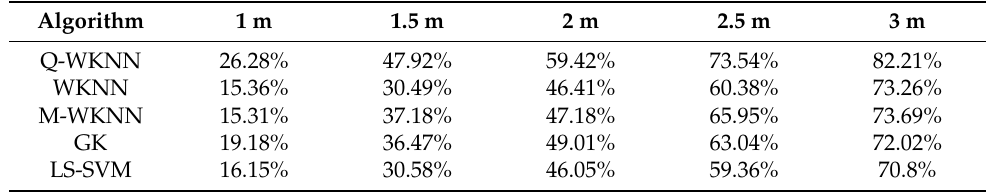
Table 4. Cumulative error probability of different algorithms under fixed accuracy limit on Zenodo.